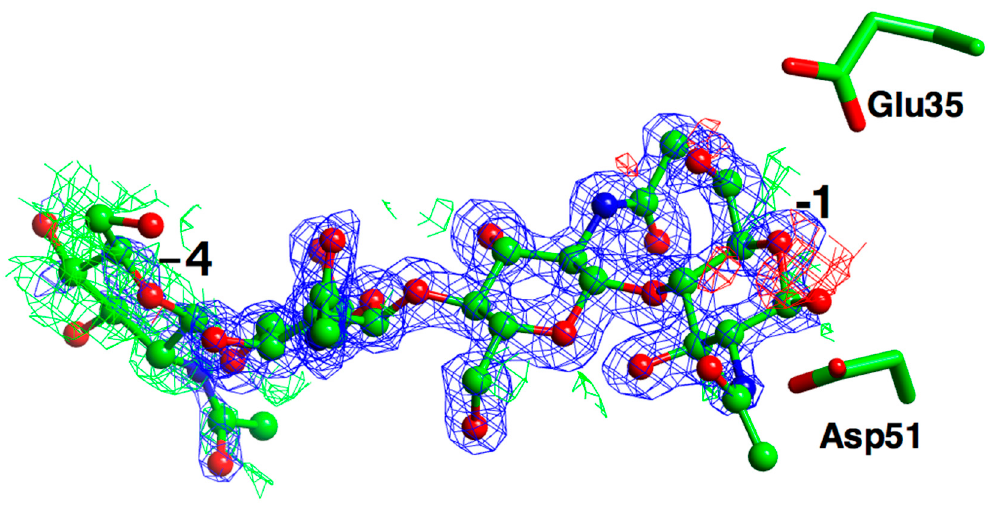
Figure 4. Electron density maps for the ligand from the crystal co-crystallised with chitohexaose. The REFMAC maximum likelihood weighted map, contoured at 1 σ , is shown in blue, the di ff erence map, contoured at 2.5 σ in green (positive), and red (negative), with phases calculated prior to the incorporation of any ligand atoms in refinement. The catalytic residues are superposed from the apo structure.